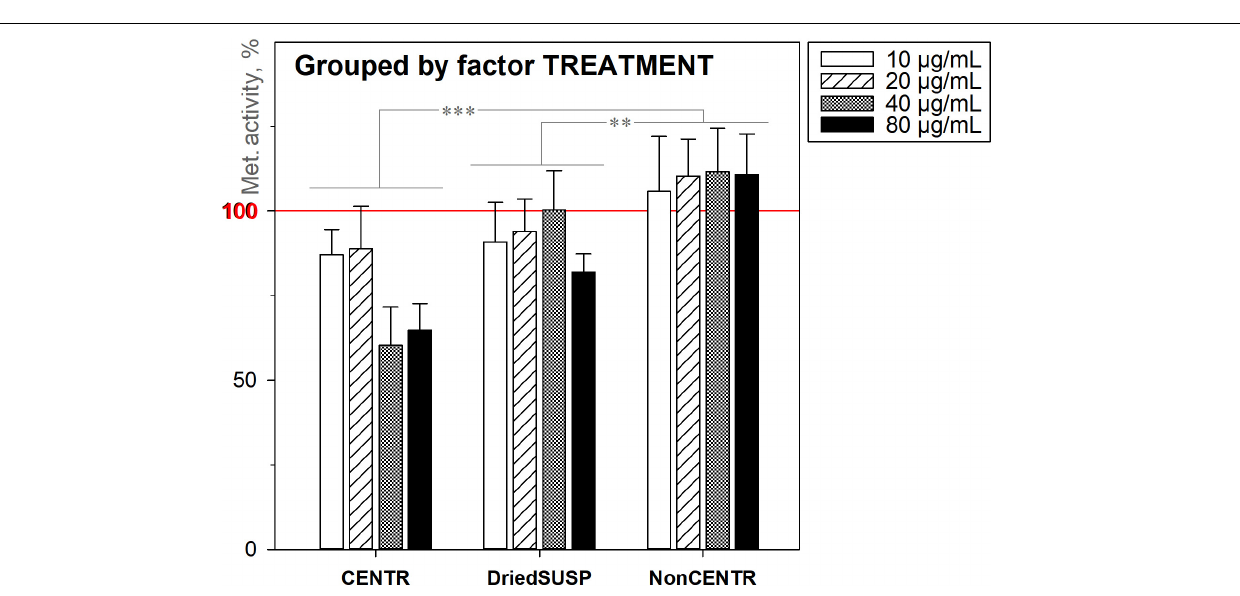
FIGURE 8 | Cell cultures of HDFs in presence of cytotoxic “H 2 S-treated” ND (above) vs. beneficial plasma-aminated ND of the same types (below). Scale bar: 100 µ m.